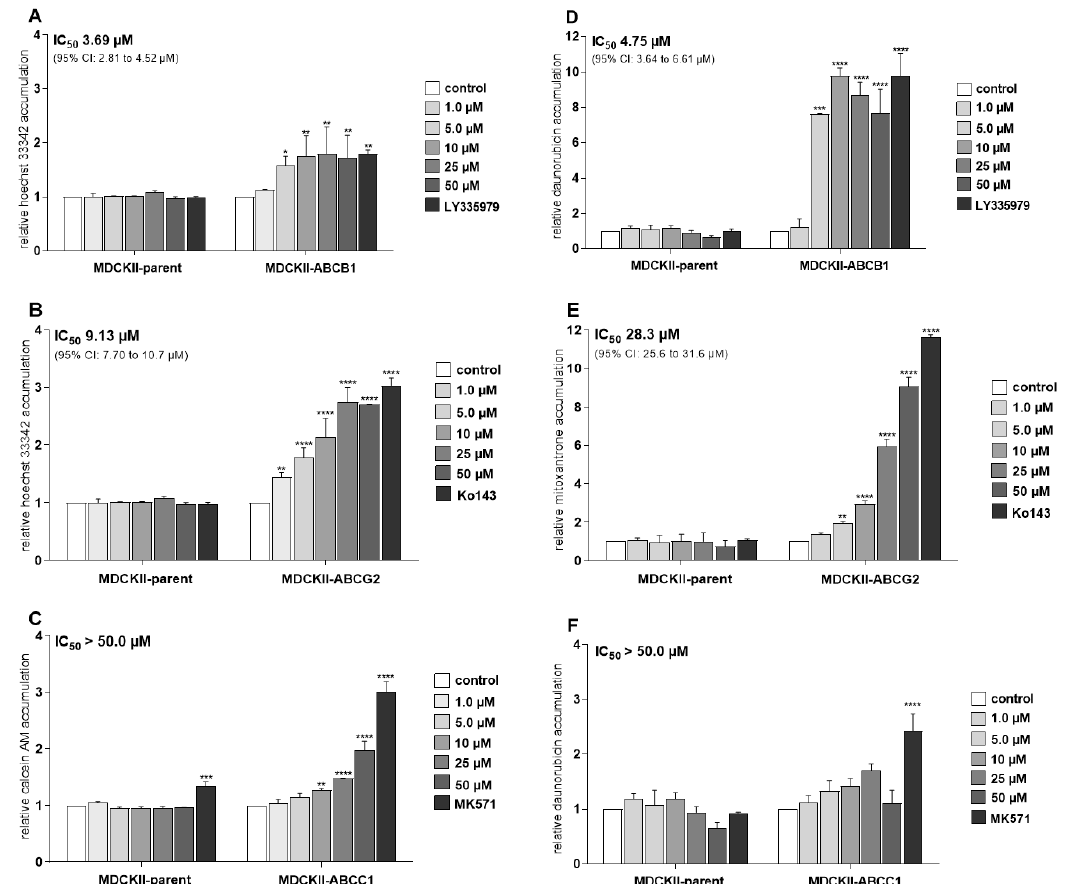
Figure 2. Effects of ensartinib on the intracellular accumulation of hoechst 33342 ( A , B ), calcein AM ( C ), daunorubicin ( D , F ) and mitoxantrone ( E ) in MDCKII cells transduced with the human ATP-binding cassette (ABC) transporters ABCB1 ( A , D ), ABCG2 ( B , E ), and ABCC1 ( C , F ). In hoechst 3342